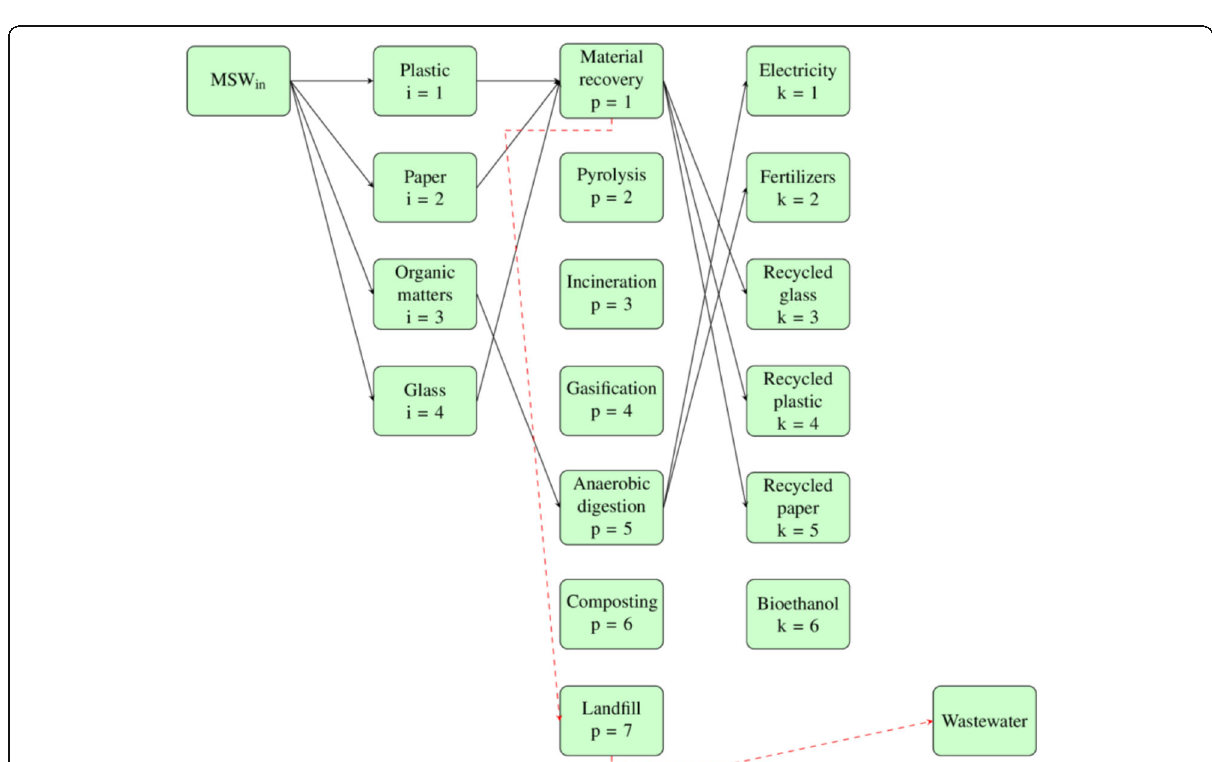
Fig. 3 The optimal waste processing configuration for Scenario